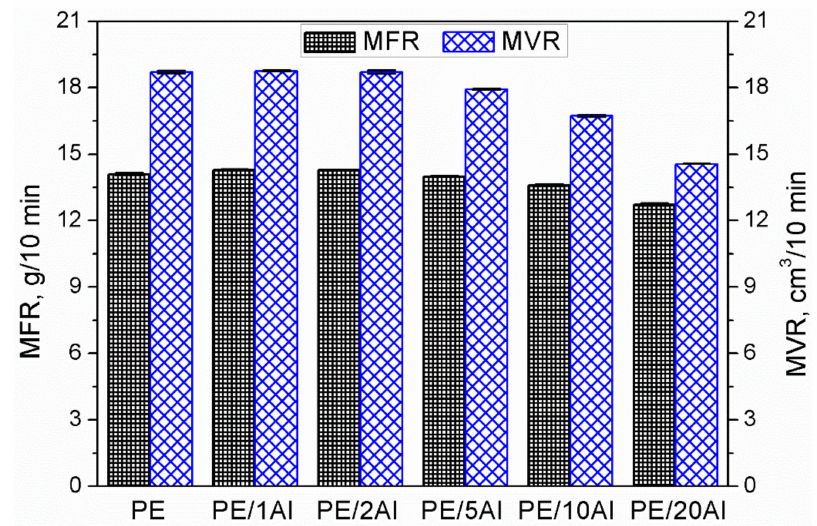
Figure 12. Melt mass-flow rate (MFR) and melt volume-flow rate volume (MVR) of prepared samples as a function of filler loading.